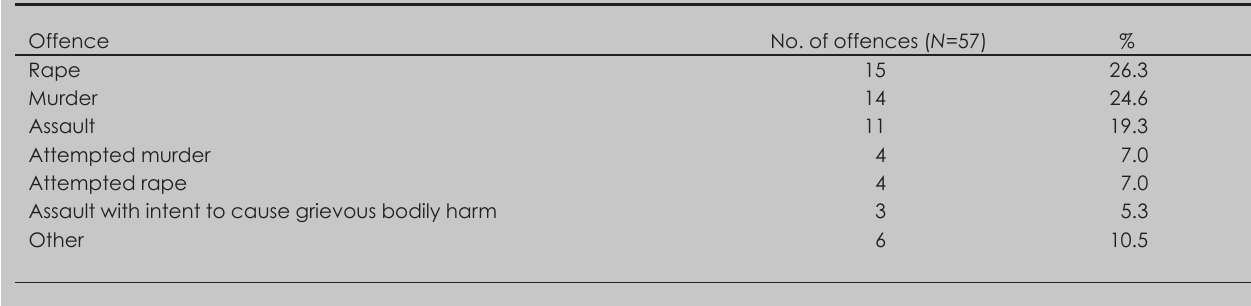
Table I. Offences committed against a person